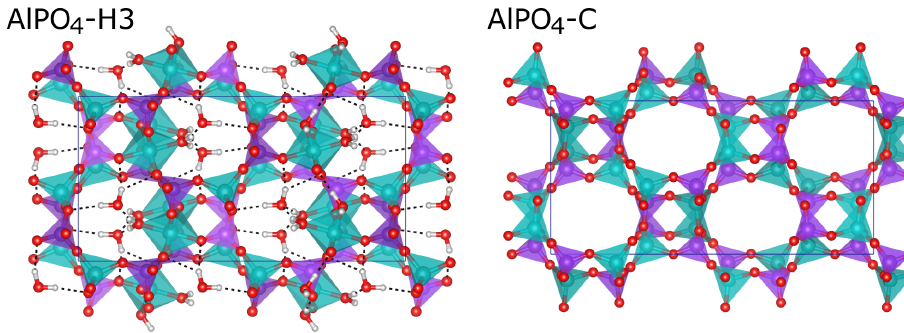
Figure 1. DFT-optimised structures of AlPO 4 -H3 and AlPO 4